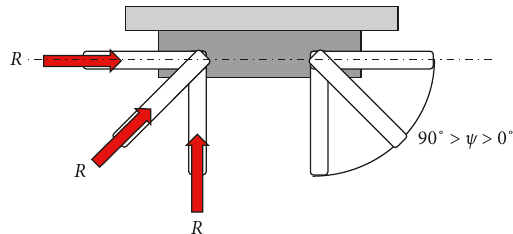
Figure 8: Front view of the NEM and angle variation [28].